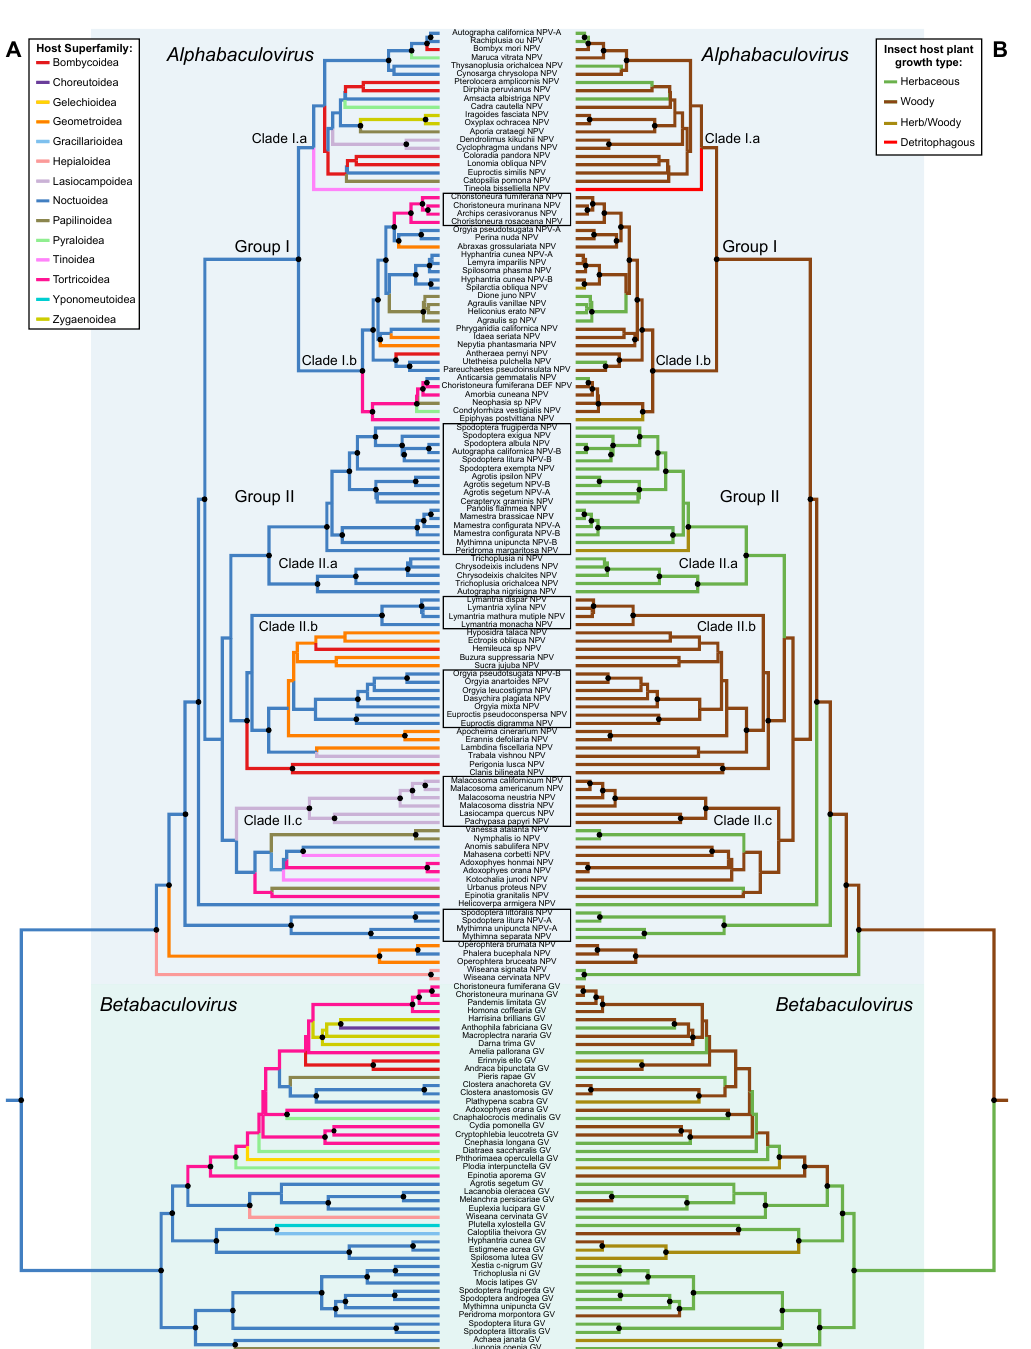
Figure 2. Phylogenetic optimizations on the lepidopteran baculovirus species tree. Optimizations were obtained by ancestral state estimation of ( A ) host Lepidoptera at superfamily level, and ( B ) insect